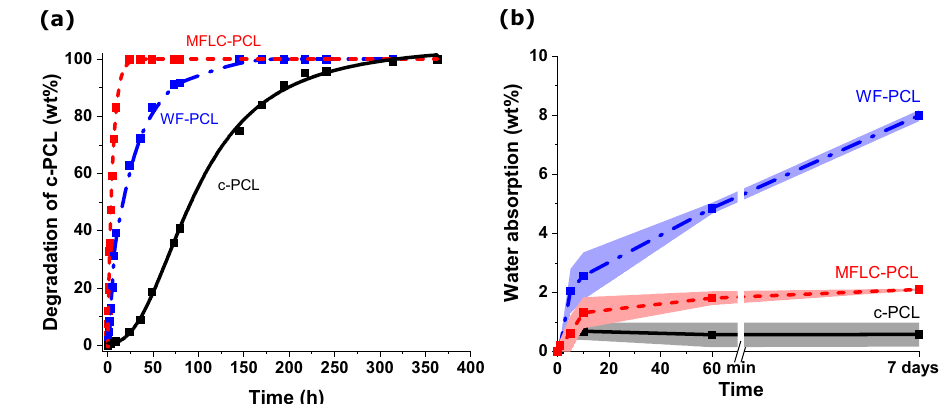
fi bers (WF) and 27% micro fi brillated lignocellulose (MFLC). b Water absorption of the homopolymer and biocomposites vs immersion time in